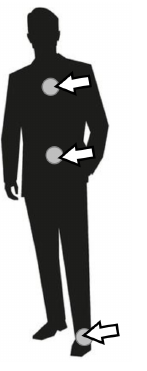
Figure 3. Placement of sensor